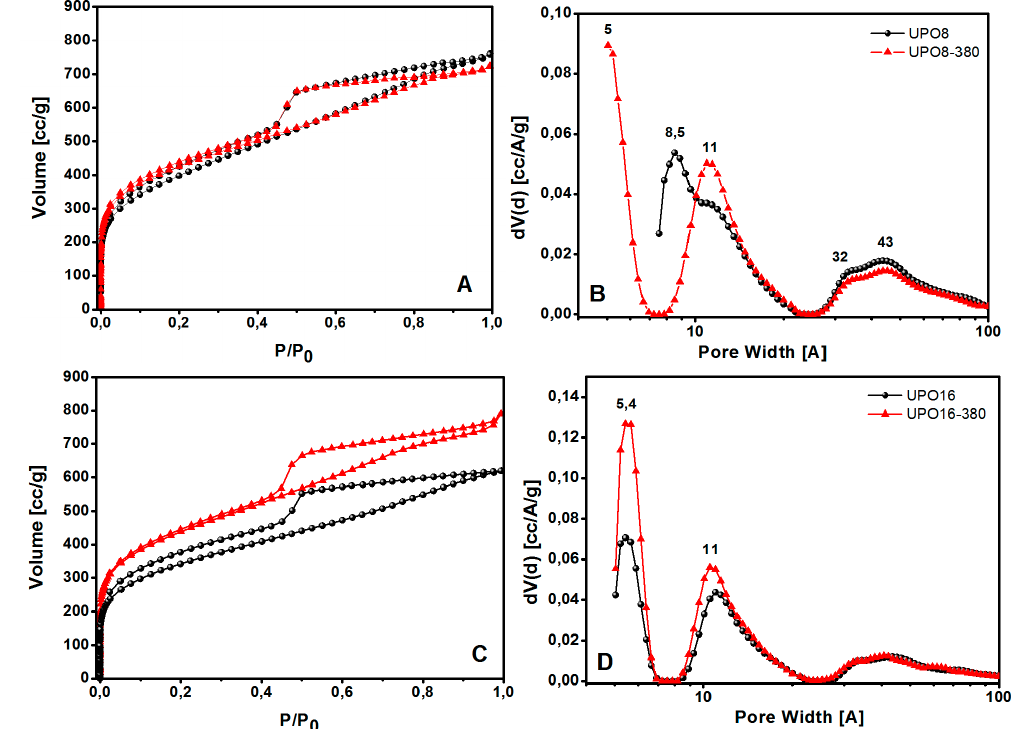
Figure 5. N 2 adsorption-desorption isotherms at 77 K and pore size distributions of UPO polymers before (black circles) and after thermal treatment at 380 °C (red triangles): ( A ) UPO8 and UPO8-380 isotherms; ( B ) UPO8 and UPO8-380 PSD; ( C ) UPO16 and UPO16-380 isotherms; ( D ) UPO16 and UPO16-380 PSD.